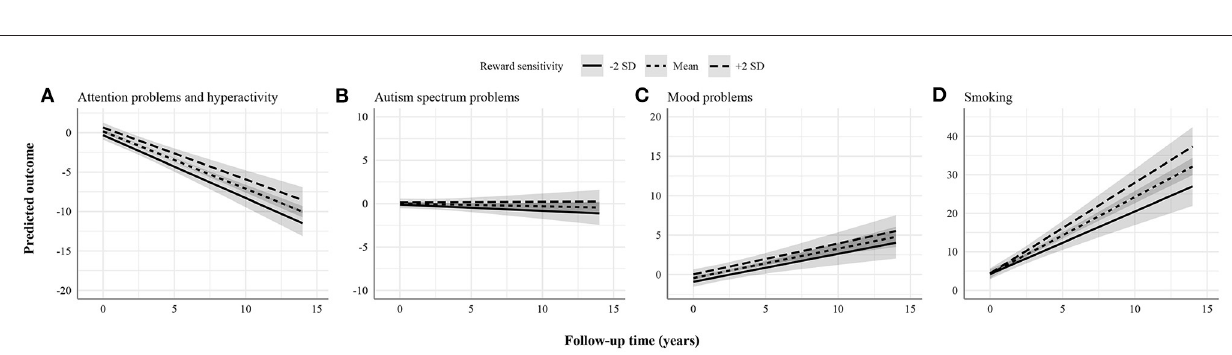
FIGURE 3 | Statistically non-significant associations between reward sensitivity and psychopathology domains. (A) Attention problems and hyperactivity. (B) Autism spectrum problems. (C) Mood problems. (D) Smoking. The figures display the effect of reward sensitivity on psychopathology based on its main effect and in interaction with time. Here, the x-axes show follow-up time in years, whereas the different lines show reward sensitivity levels at 2 SD above and below the mean. The y-axes represent the predicted outcome with all covariates at mean levels and sex coded as 0 (males). The y-axes are only partly shown for better visualization of the